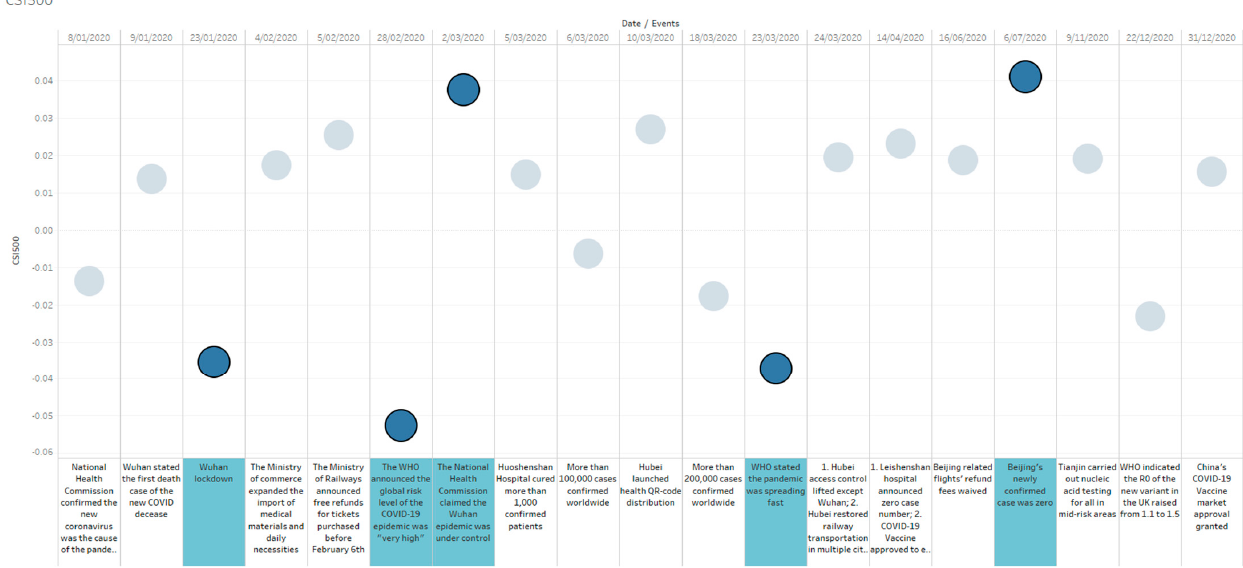
Figure 2. CSI500’s trends on relevant social events.